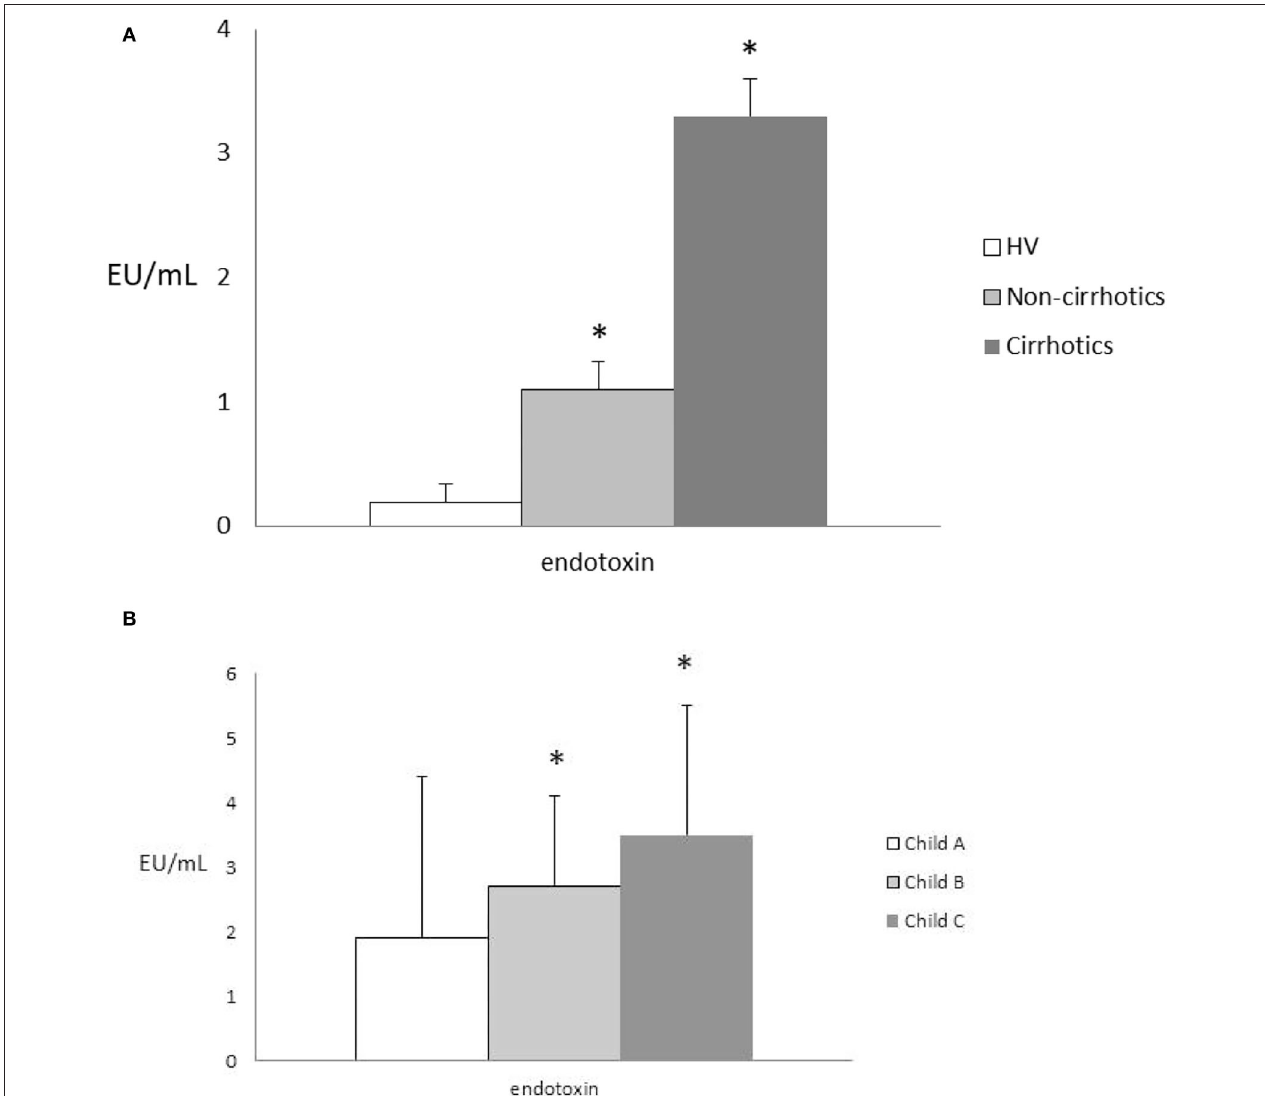
FIGURE 2 | (A) Endotoxin levels in the HVs vs. the cirrhotic and non-cirrhotic patients; all * p < 0.05. HVs, healthy volunteers. (B) Endotoxin levels according to Child-Pugh status in the cirrhotic patients; all, * p < 0.05. Comparisons between endotoxin values were made by the Kruskal-Wallis test and the post-hoc Dunn test.